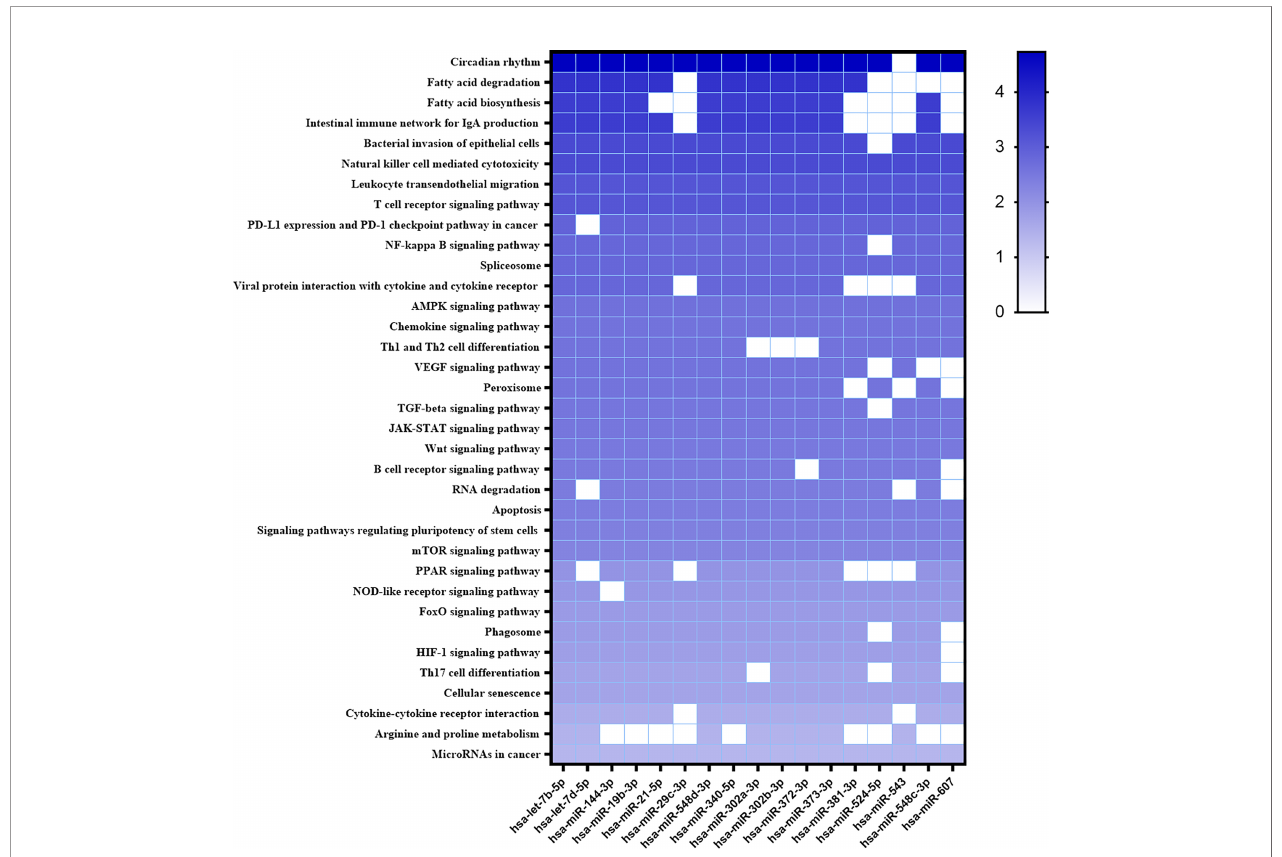
FIGURE 3 | Heatmap of predicted interactions between differentially expressed miRNAs in infected THP-1 cells. The set of differentially expressed microRNAs in L. infantum -infected THP-1 at 6 and 24 h and the biological pathways on which they are suggested to act, according to MiEAA algorithms, are shown in heat map format. Results are shown as -log10 of prediction p-value, and the degree of color saturation corresponds to the -log10 of the